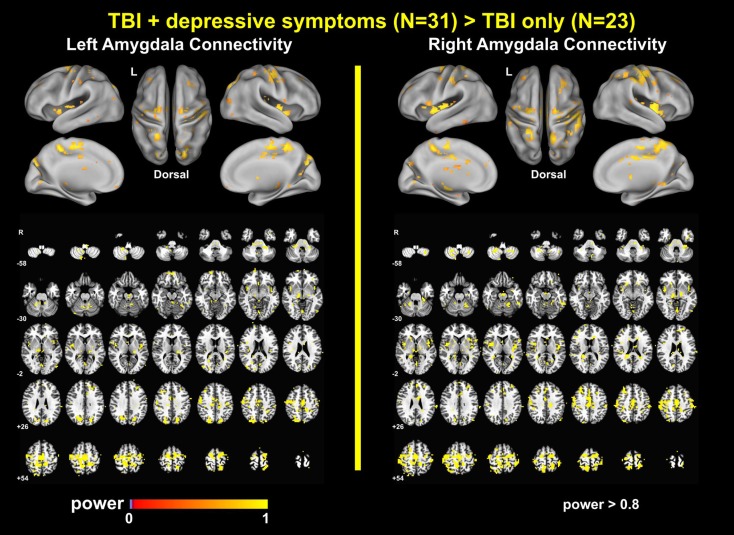
Observed power for group differences in amygdala connectivity.